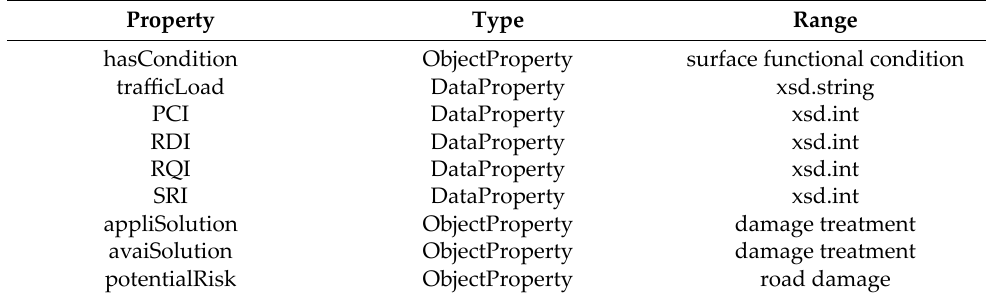
Table 1. Main properties of the urban road.